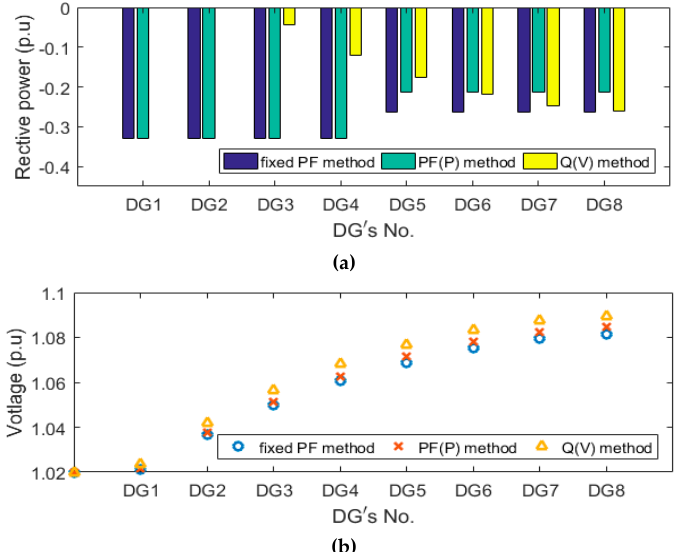
Figure 5. ( a ) Reactive power output; and ( b ) node voltage of distributed generators with different